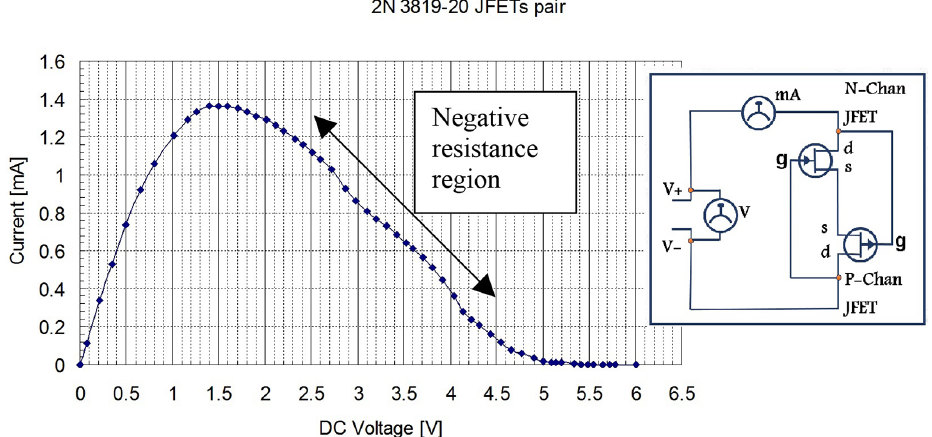
Figure 22. The 2N3819 and 2N3820 JFET pair lambda diode characteristic. Electronic circuit design published by Butler (1997).